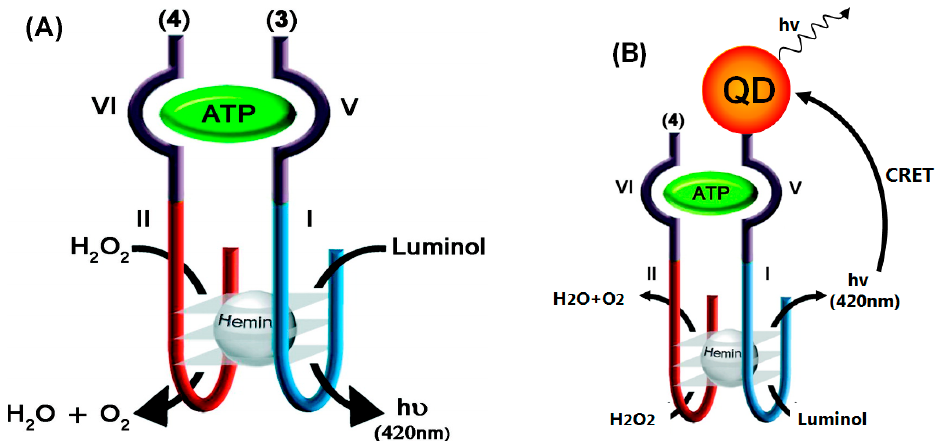
Figure 5. ( A ) Chemiluminescent analysis of ATP. Two subunits are the conjugated anti-ATP and